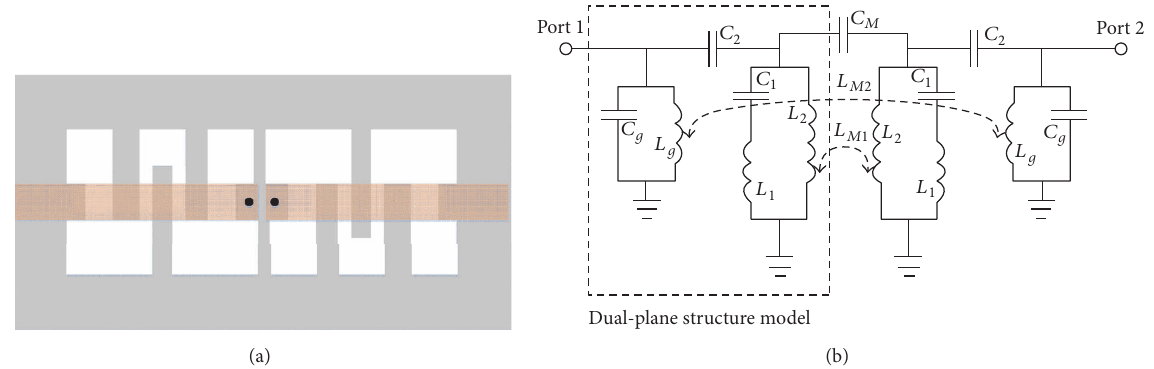
Figure 17: BPF with interdigital slot DGS. (a) Layout. (b) Equivalent circuit model [57].